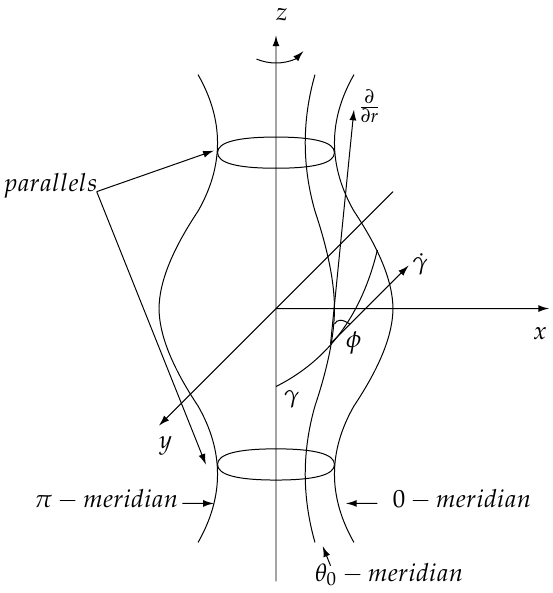
Figure 5. The angle φ between ˙ γ and a meridian for a cylinder of